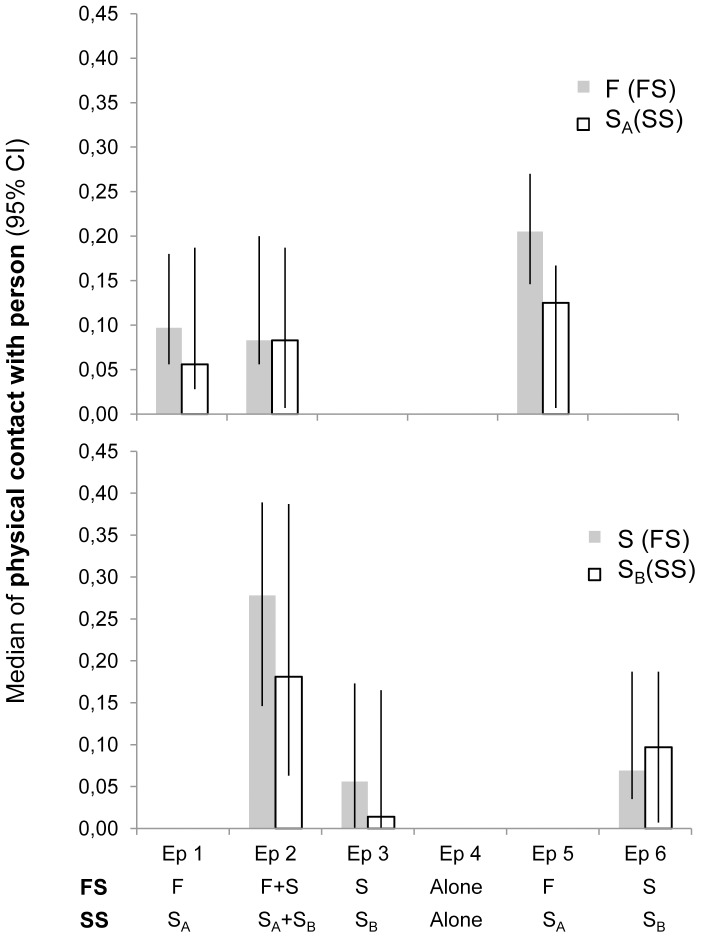
The level of physical contact with humans initiated by dog in both treatments.Time spent in physical contact with person (median proportion of sample points/episode presented together with 95% confidence intervals) during the whole test procedure (episodes (Ep) 1–6) in treatment FS and in treatment SS. F = familiar person, S = stranger, SA = stranger A and SB = stranger B.